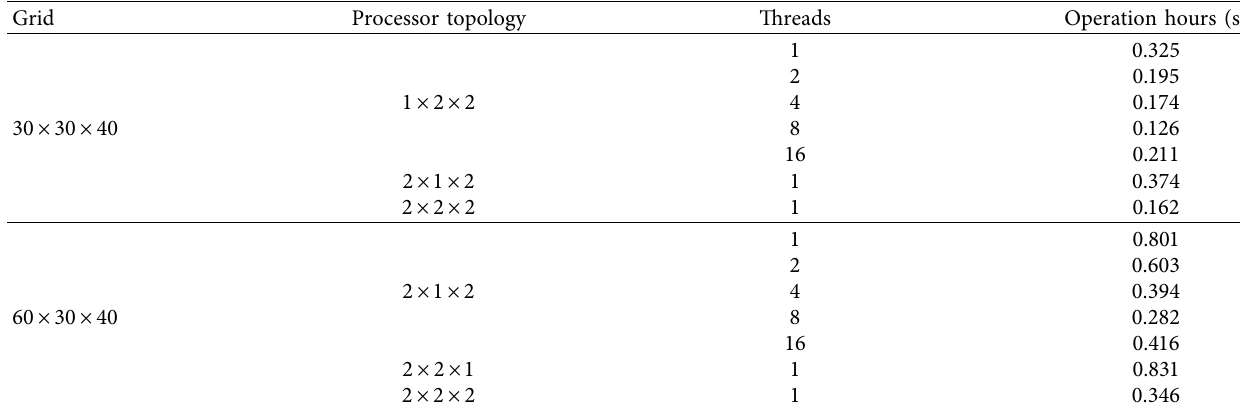
Figure 9: Improvement effect comparison chart. Table 4: Test results of LM3D hybrid program on a supercomputer.